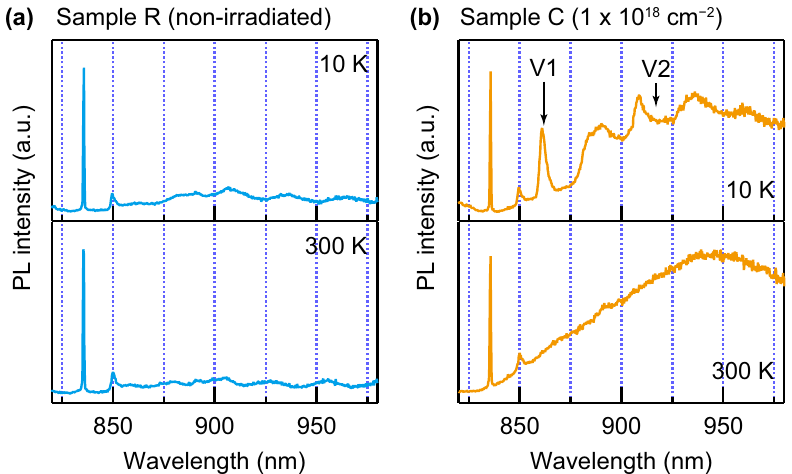
Figure 4. Photoluminescence (PL) spectra with a 785-nm excitation laser at room temperature. The excitation energy is 3.7 mW at the top surface of the samples. The PL spectrum for the (a) non-irradiated and 18 cm − 2 (b) 1 × 10 -irradiated samples. Measurements were performed at temperatures of 10K (upper panel) and 300 K (lower panel). The V 1 zero-phonon line of the silicon-vacancy defects is clearly seen at 10K for the irradiated sample. The emission lines at 836 nm and 850 nm originate from the Raman scattering of 4H-SiC 30